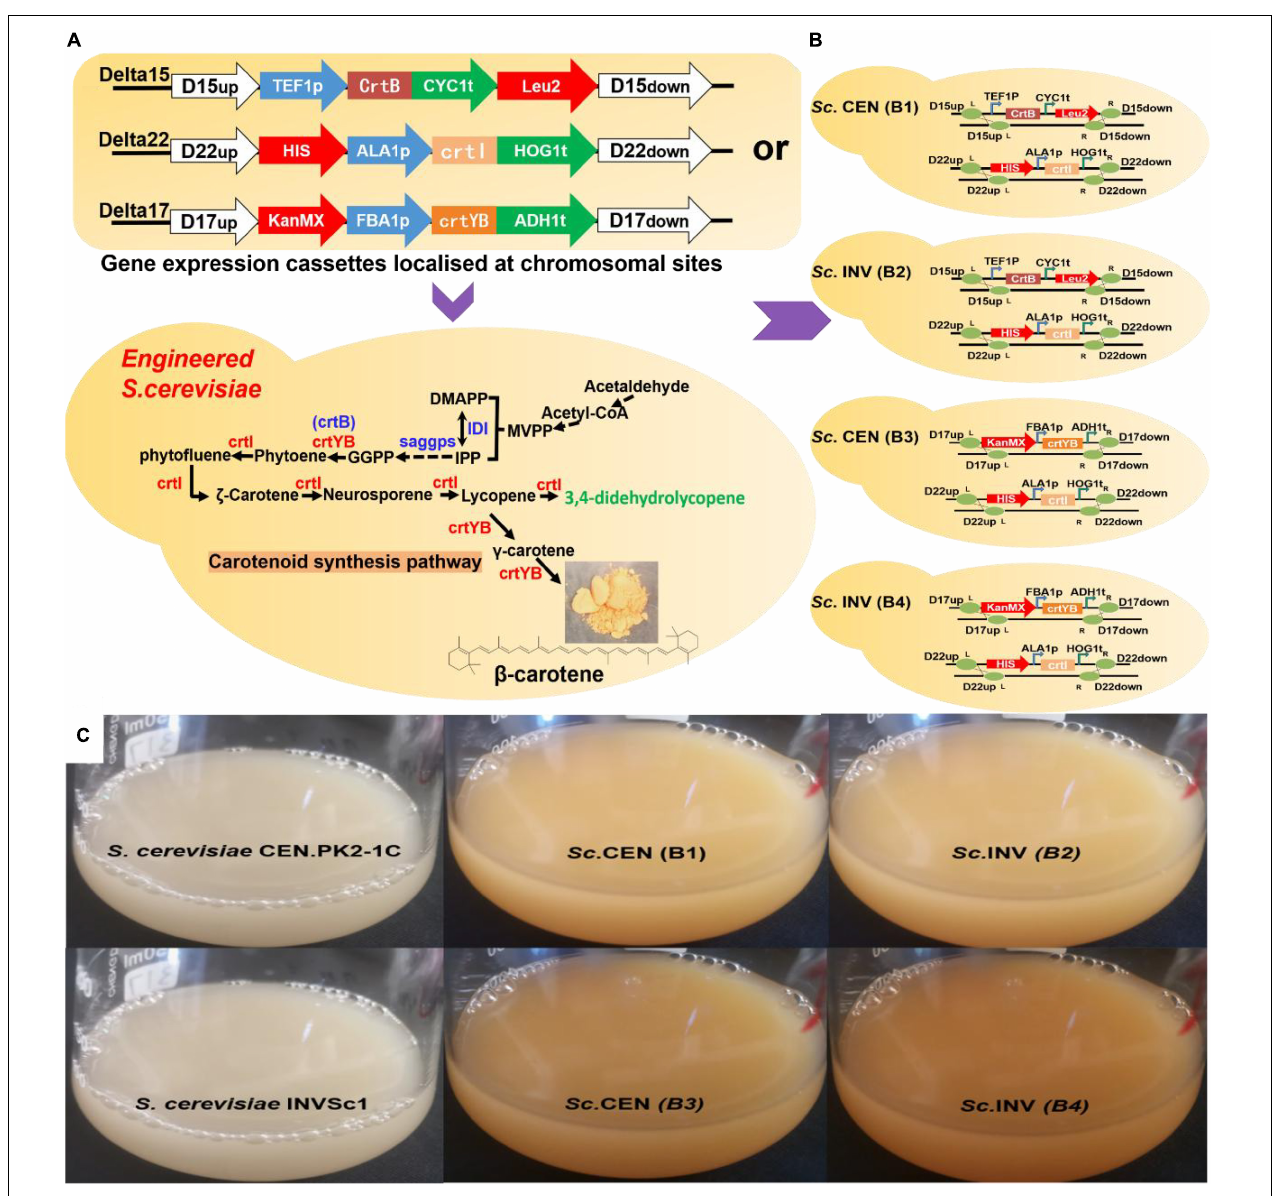
FIGURE 5 | Validation of gene function in Saccharomyces cerevisiae . (A) Gene expression cassettes are constructed and transferred to chromosomal locations in S. cerevisiae by homologous recombination methods. (B) Specific genotype of engineered strains. Sc . CEN (B1), Sc . INV (B2), Sc . CEN (B3), and Sc . INV (B4). (C) Picture after 118 h of shake-flask fermentation: S. cerevisiae CEN.PK2-1C, S. cerevisiae INVSc1, Sc . CEN (B1), Sc . INV (B2), Sc . CEN (B3), and Sc . INV (B4).